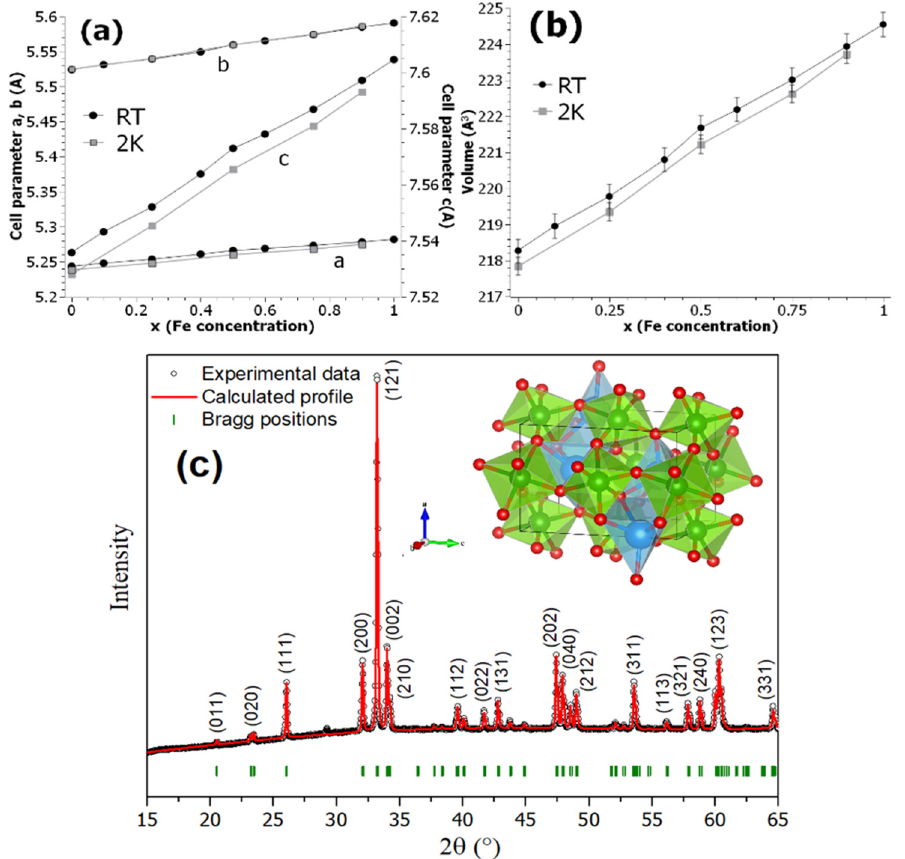
Figure 1. Cell parameter ( a ) and volume ( b ) variation with the x (Fe concentration) and Rietveld refinement XRD diffractogram ( c ) for the RS7 sample. The inset in ( c ) is the simulated structure obtained after refinement using VESTA (red spheres are oxygen atoms, white and blue are yttrium atoms, and green spheres are iron atoms). While blue, red, and green arrows indicate the a, b, and c crystallographic axes, respectively. Miller indexes are given between parentheses, black dots are the experimental data, the red line is the calculated diffractogram, and the vertical green lines are the Bragg’s diffraction position. Solid lines in ( a ) and ( b ) are guides for visualization. The obtained profile refinement gave acceptable statistical parameters for the reliability factor, R p (%); weighted profile residual, Rw p (%); expected profile residual, R exp (%); and goodness of fit, χ 2 ; having quantitative values as follows: R p = 16.2%, R wp =